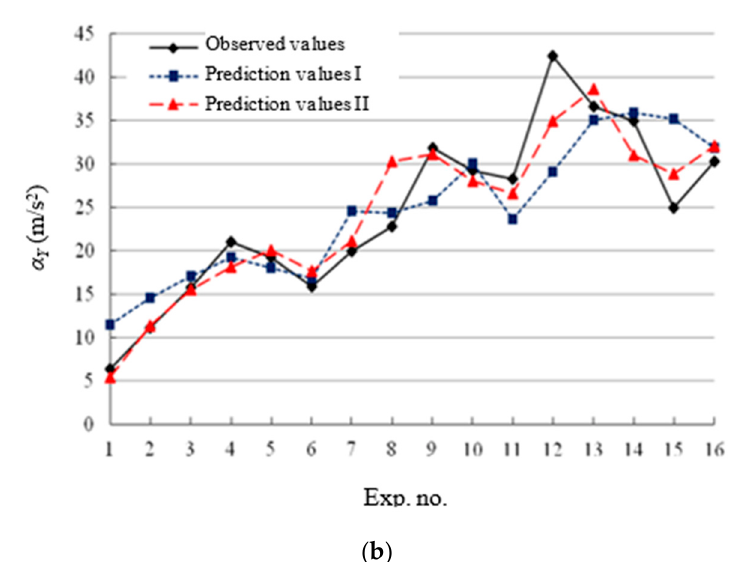
Figure 5. Comparison between prediction values and observed values. ( a ) feed acceleration vibration α X . ( b ) transverse acceleration vibration α Y .